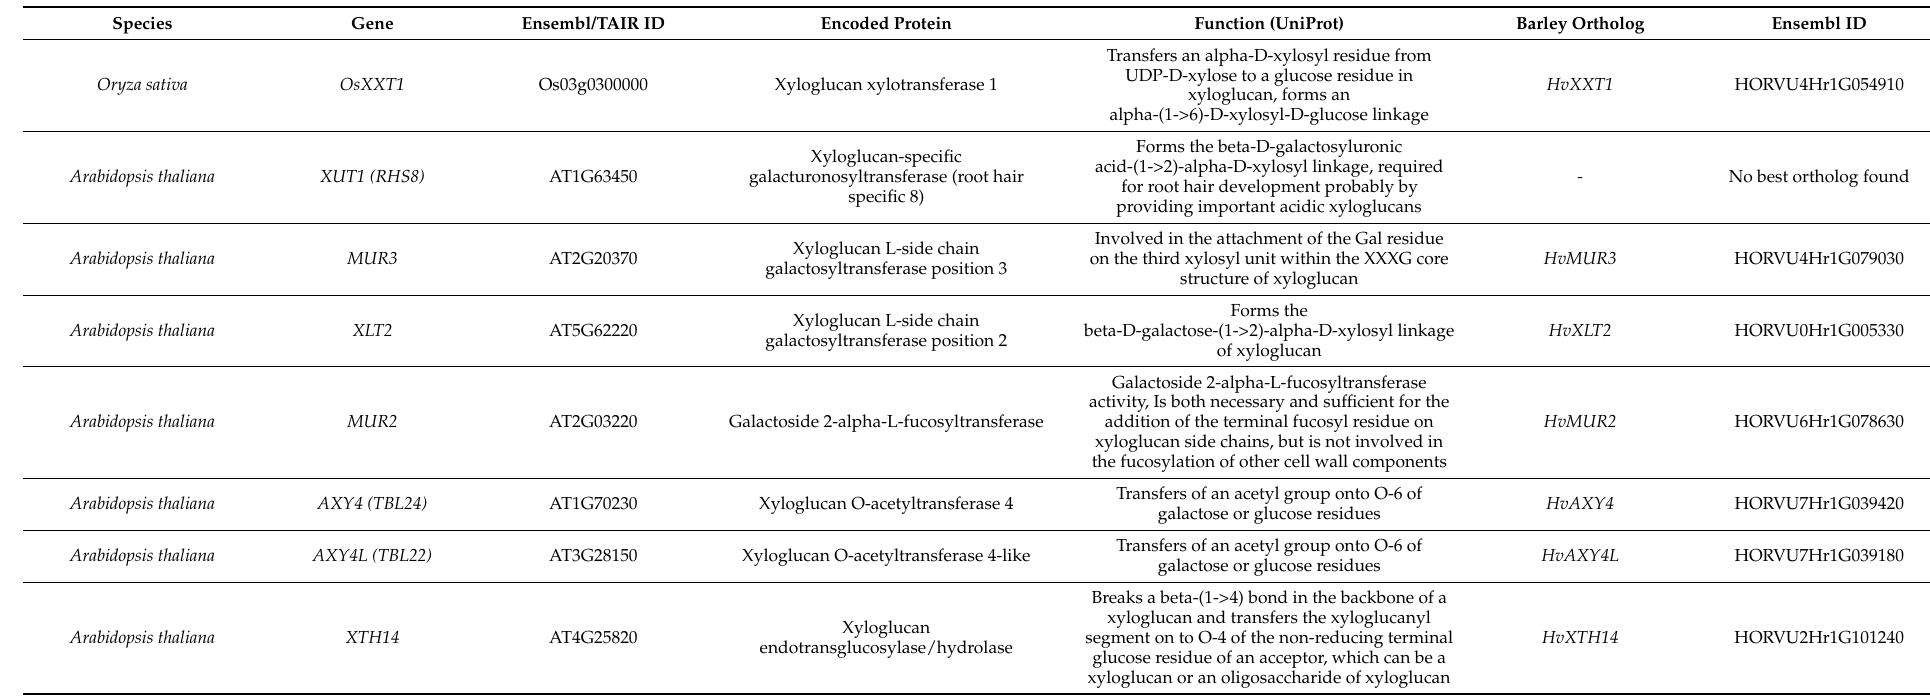
Table 2. The candidate genes selected for expression analysis potentially involved in XyG biosynthesis in barley root